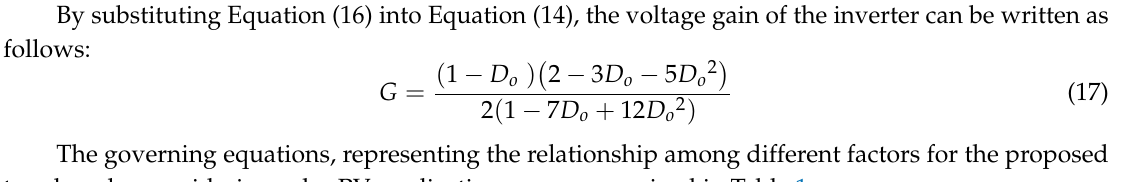
Table 1. Governing equations of SL-SBZSI.